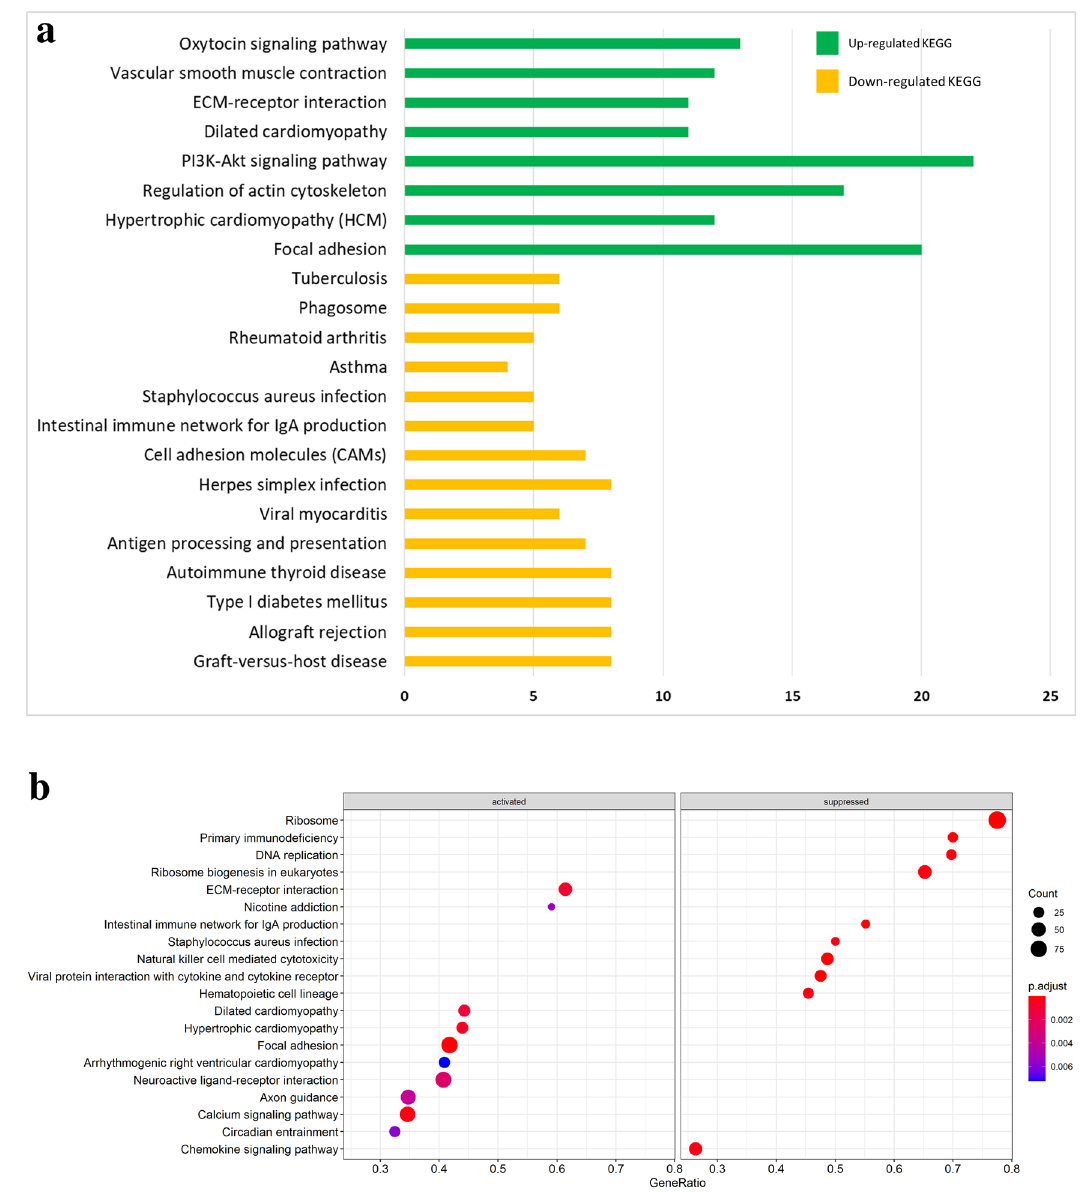
Figure 6. Functional enrichment analysis for KEGG pathways in the HD samples. ( a ) Analysis with DAVID using the up-regulated DEGs and down-regulated DEGs as the input data; the values on the x-axis represent the number of genes associated with each significant KEGG pathway. ( b ) Analysis with GSEA utilizing the entire DESeq2-normalised dataset; the top 20 significantly enriched KEGG pathways are shown in this